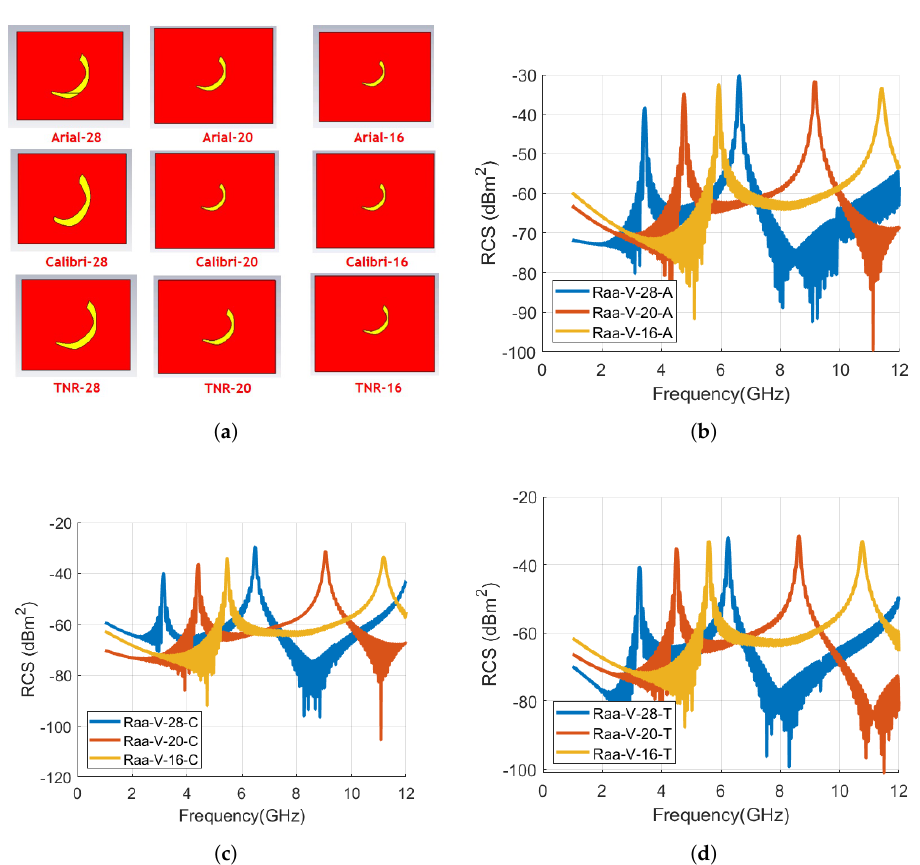
Figure 18. Designed letters and comparison of RCS results of alphabet P tag for vertical polarization with various font types and sizes: ( a ) Designed letter P tag with various fonts and sizes; ( b ) RCS results of Arial font with 28, 20, and 16 sizes; ( c ) RCS results of Calibri font with 28, 20, and 16 sizes; and ( d ) RCS results of Times New Roman (TNR) font with 28, 20, and 16 sizes. The comparison of the RCS vertical polarization spectral components for the alphabet tag Ł with the change in tag size for the realized font types is depicted in Figure 19. Table 9 illustrates the obtained resonant frequencies from the waveforms of Figure 19.